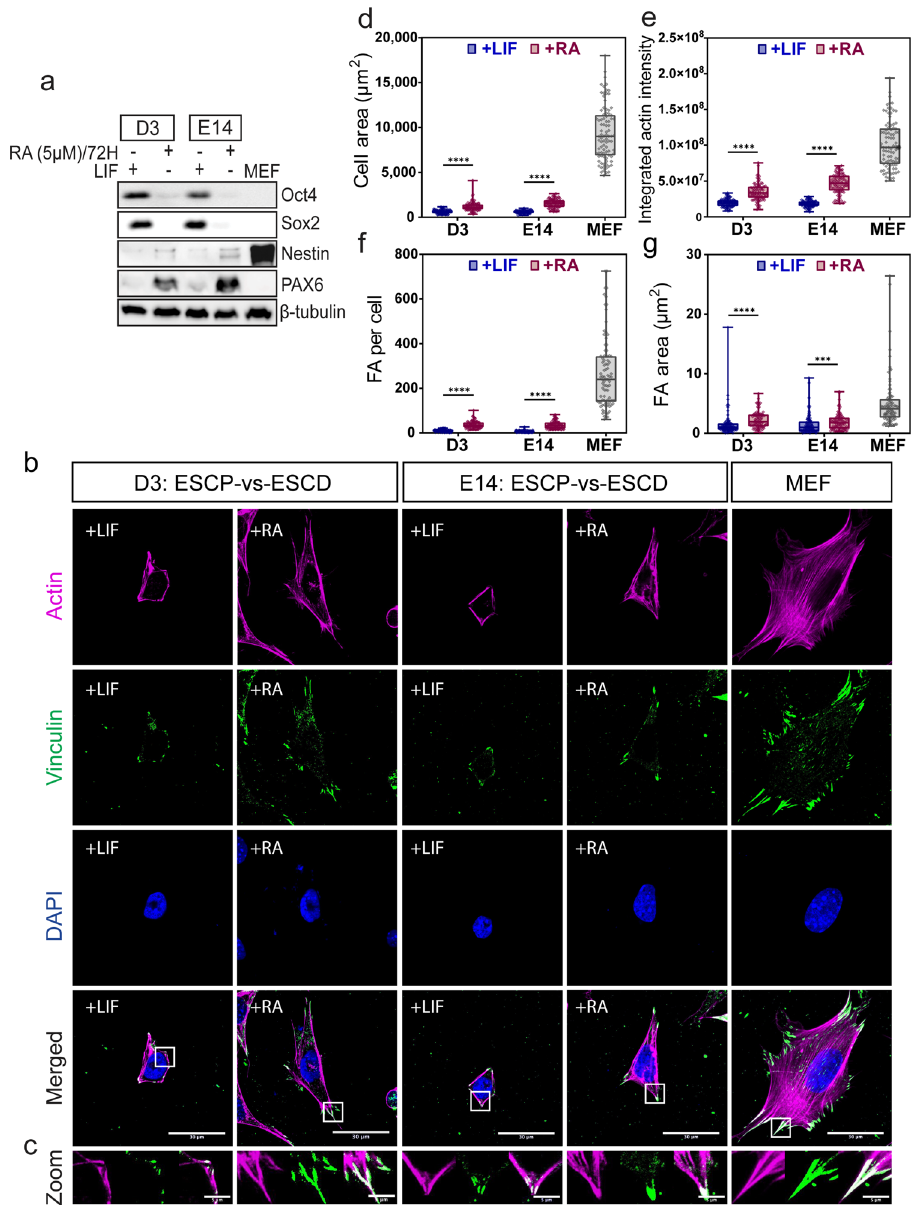
Fig. 1 Comparison of focal adhesions and actin structures between pluripotent mESC (ESCP) and RA-induced differentiated mESC (ESCD). a D3 and E14 cells were treated with retinoic acid (RA) for up to 72 h at a concentration of 5 μ M. Leukemia Inhibitory factor (LIF) was used to maintain pluripotency of mESC. MEF was used as the specialized cell type for comparison. Pluripotency markers (Oct4, Sox2) and early differentiation markers (Nestin, Pax6) were examined by western blot. β -tubulin was used as loading control. b Examination of focal adhesion and actin cytoskeleton were conducted by immuno fl uorescence, using antibodies against vinculin (green) and Phalloidin-Alexa 546 to visualize focal adhesions and actin (magenta), respectively. c Boxed regions in merged picture ( b ) were zoomed in and shown here. The experiments were conducted in triplicates. Z-stacked images with maximum intensity projection were shown. Scale bar: 30 μ m for original images, 5 μ m for zoomed-in images. d projected cell area, e integrated actin intensity, f number of focal adhesions per cell, g projected focal adhesion area were measured ( N = 90). Quanti fi ed data were averaged from three independent experiments. Two-tailed unpaired Student ’ s t -test and Mann – Whitney U -test were used to test the differences between the + LIF and + RA groups. In the box and whisker plots, the center line is the median, the box-bounds are the 25th and 75th percentiles, and the whiskers are the 0.05 and 0.95 percentiles. *** P ≤ 0.001; **** P ≤